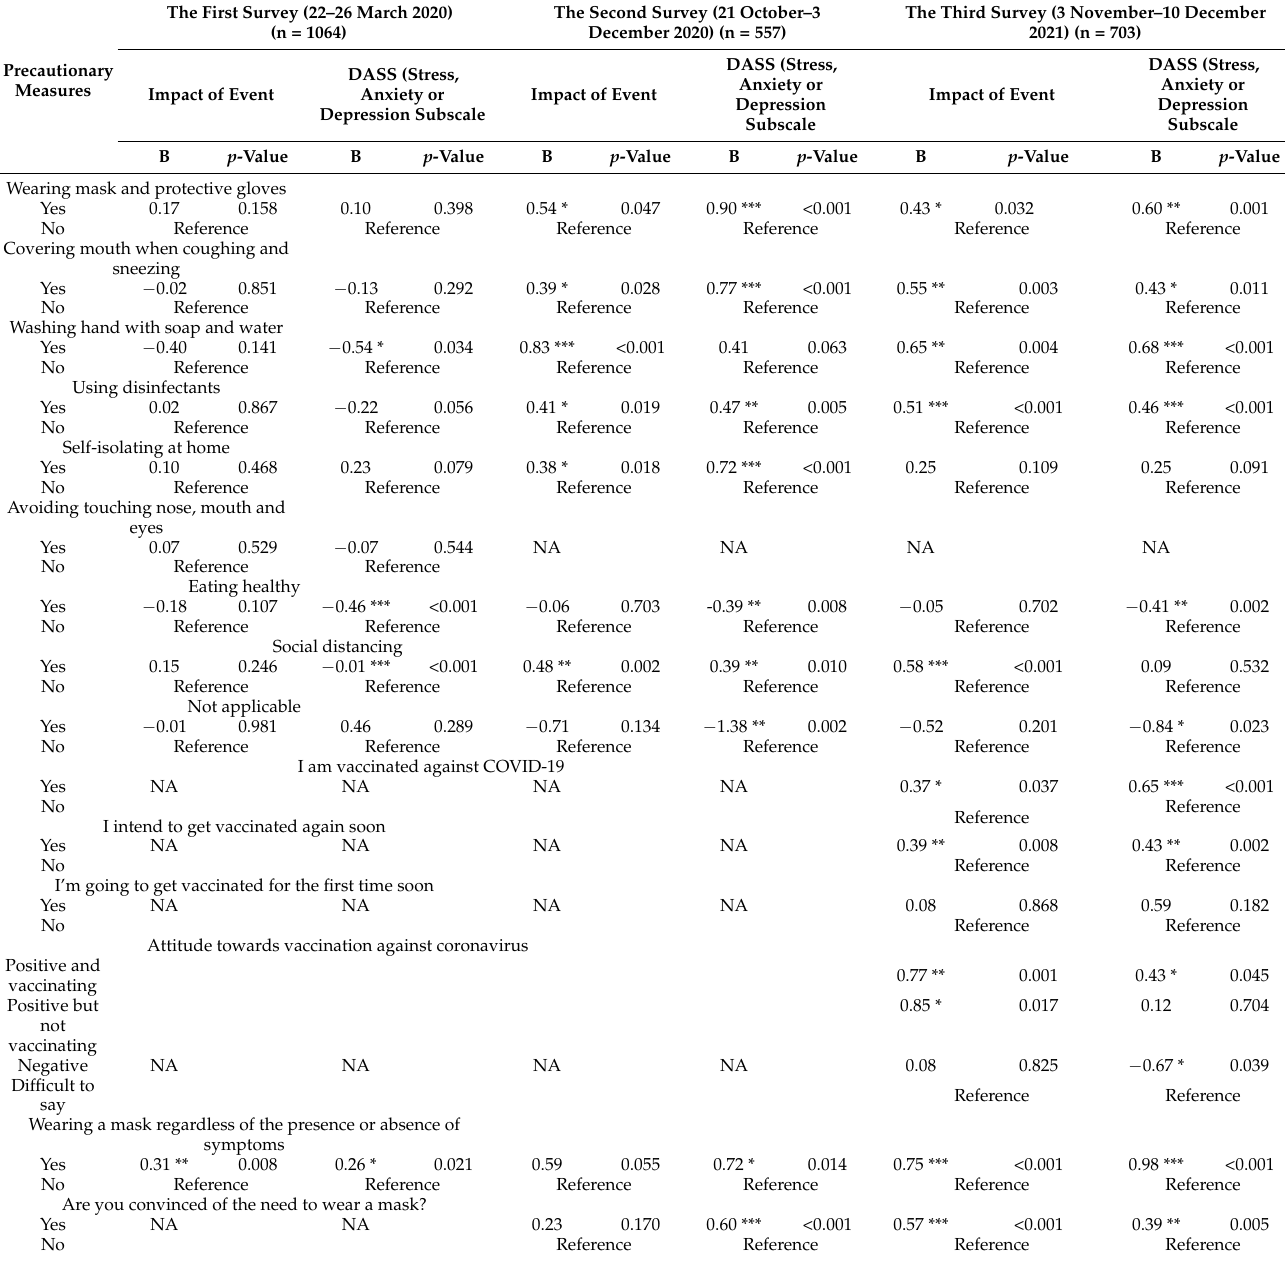
Table 4. Association of precautionary measures related to COVID-19 and the psychological impact as well as adverse mental health status during the first, second and third surveys (n =